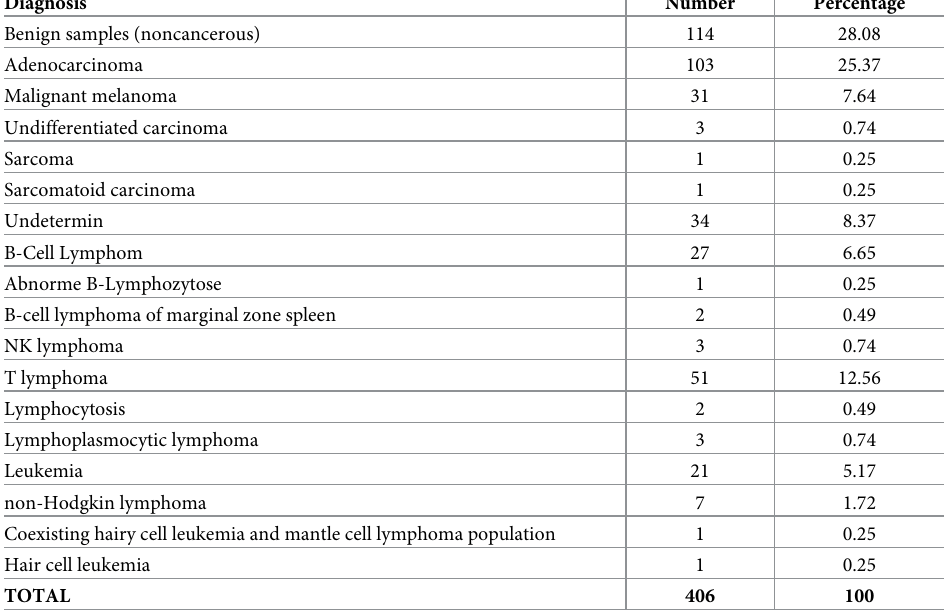
Table 1. List of 406 samples stored at the Pathology Department at Freiburg Uniklinik, Germany during the period 2008–2012, distributed by diagnosis.